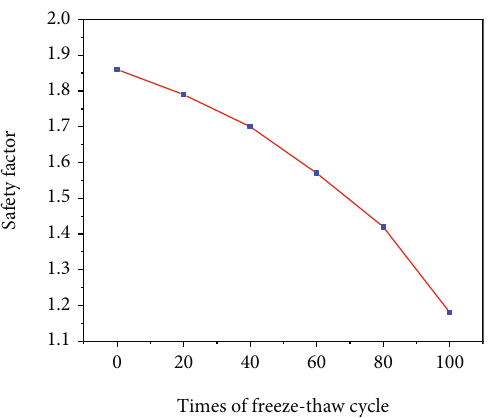
Figure 19: Relationship between safety factor and times of the freeze-thaw